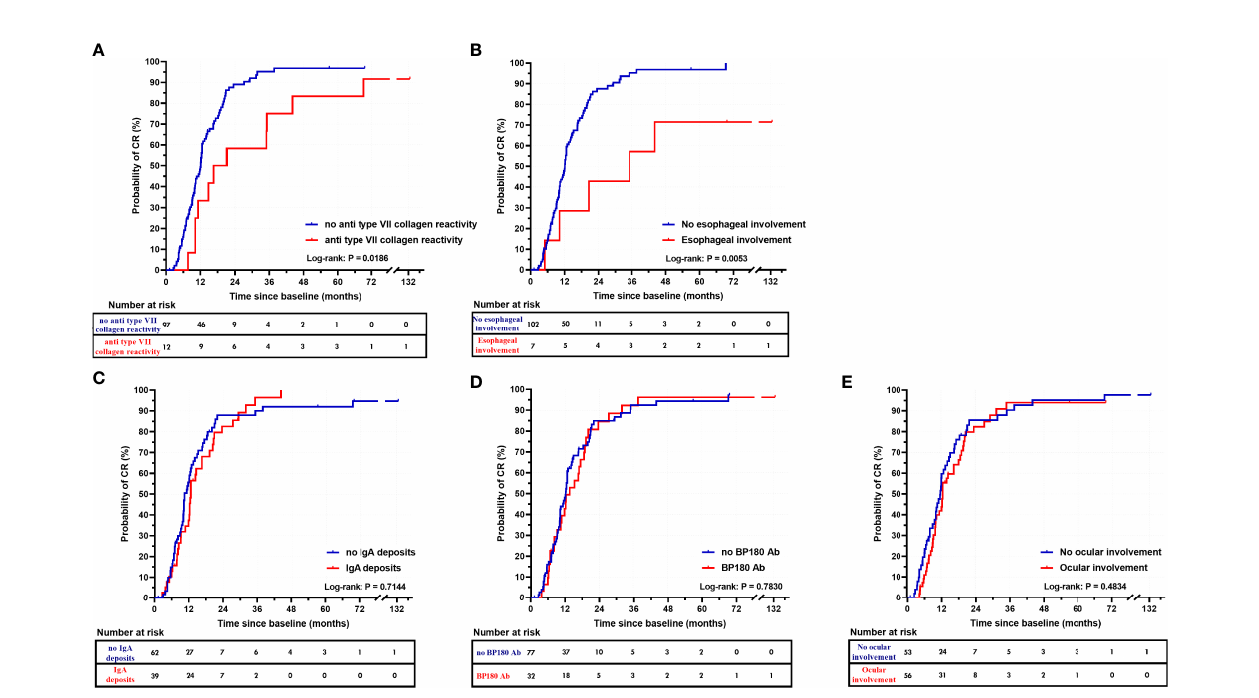
FIGURE 4 | Kaplan-Meier survival curves for complete remission. Survival curves for complete remission in patients with MMP with anti-type VII collagen reactivity and MMP without anti-type VII collagen reactivity (A) , and depending on the presence of esophageal involvement (B) , IgA deposits in DIF or DIEM (C) , circulating anti-BP180 antibodies (D) , or ocular involvement (E)